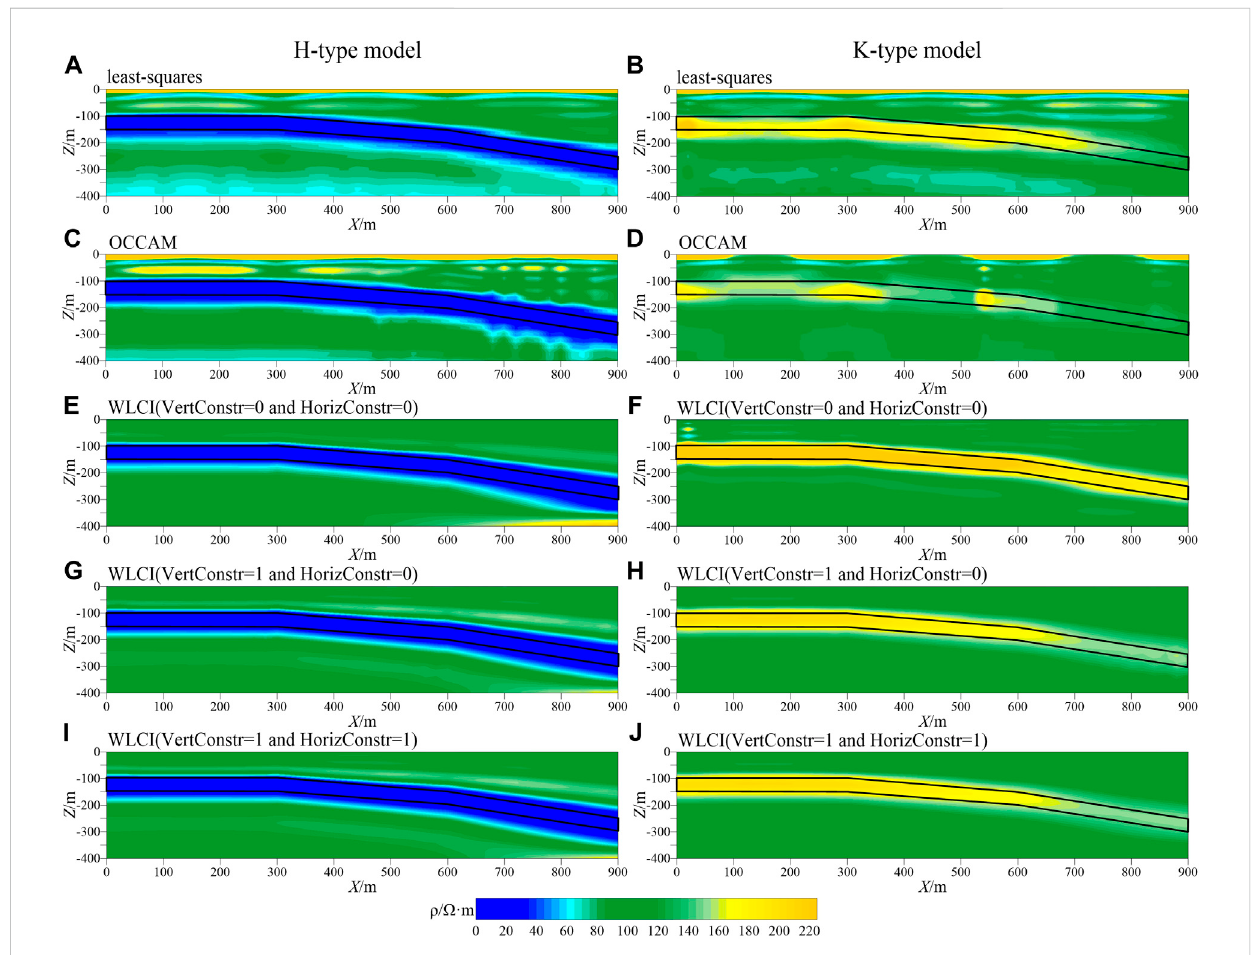
FIGURE 4 Inversion results of H-type and K-type models. (A) : least-squares inversion result of H-type model. (B) : least-squares inversion result of K-type model. (C) : OCCAM inversion result of H-type model. (D) : OCCAM inversion result of K-type model. (E) : WLCI inversion result of H-type model while vertical constrained factor is 0 and horizontal constrained factor is 0. (F) : WLCI inversion result of K-type model while vertical constrained factor is 0 and horizontal constrained factor is 0. (G) : WLCI inversion result of H-type model while vertical constrained factor is 1 and horizontal constrained factor is 0. (H) : WLCI inversion result of K-type model while vertical constrained factor is 1 and horizontal constrained factor is 0. (I) : WLCI inversion result of H-type model while vertical constrained factor is 1 and horizontal constrained factor is 1. (J) : WLCI inversion result of K-type model while vertical constrained factor is 1 and horizontal constrained factor is